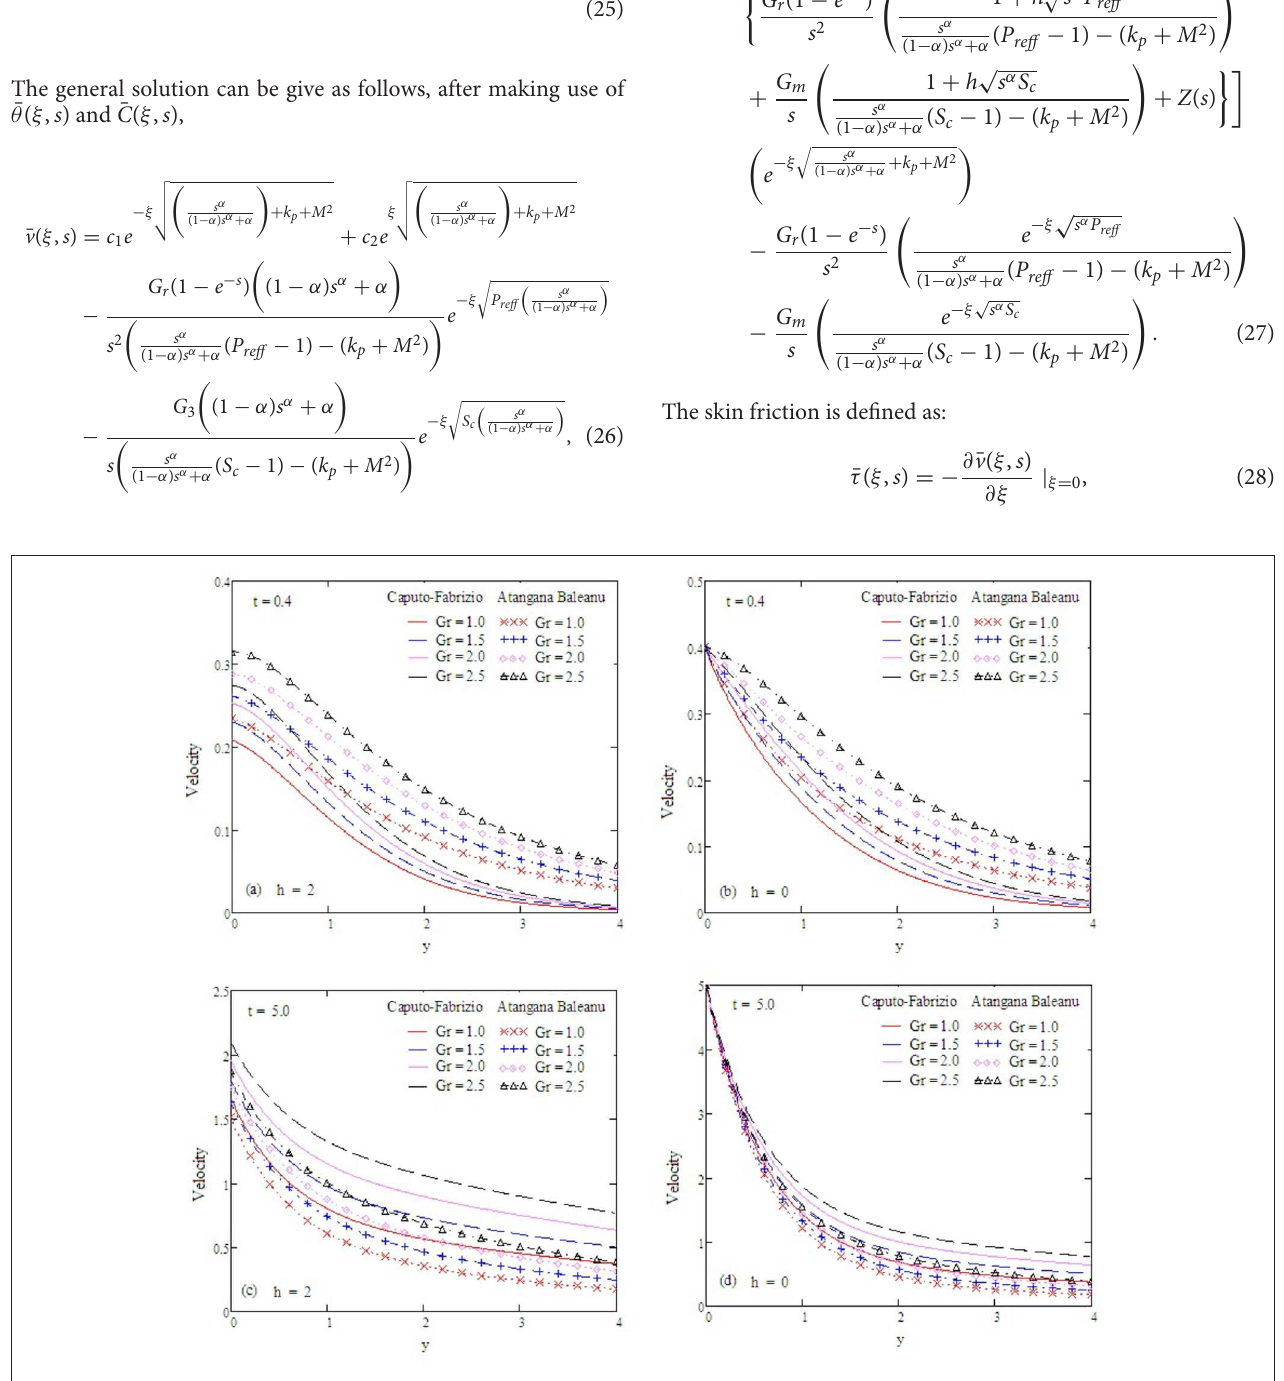
FIGURE 5 | Velocity profiles with altered values of G r and other parameters are k p